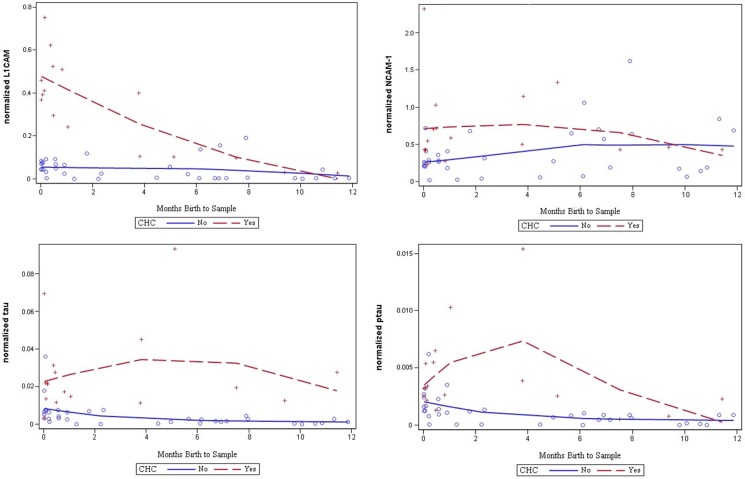
Relationship of CSF biomarker levels to congenital hydrocephalus and age at CSF sample.Regression analysis of normalized CSF L1CAM, NCAM-1, tau, and phosphorylated tau (pTau) levels and age at sample (in months) in congenital hydrocephalus (CHC, shown in red) and non-CHC groups (control and other neurological diseases subjects, shown in blue). Note that these proteins exhibited a similar pattern as APP and its isoforms by being most different in CHC <12 months of age.